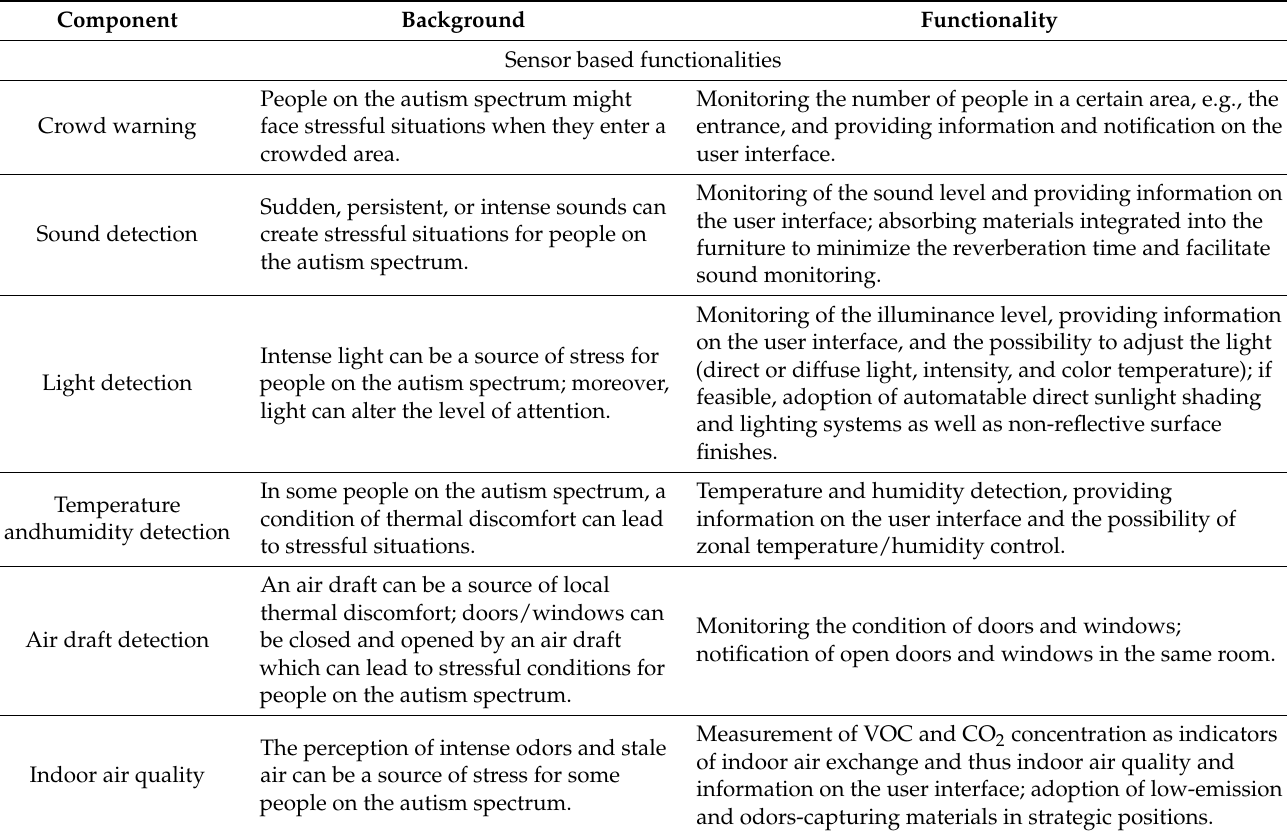
Figure 6. Design images of the SENSHOME furniture: table with dividers ( a ); TV cabinet ( b ); refuge seat ( c ); ceiling lamps ( d ); lighting pictograms ( e ); threshold cabinet ( f ); visual agenda ( g ); and entrance wardrobe ( h ). Table 4. Overview of SENSHOME